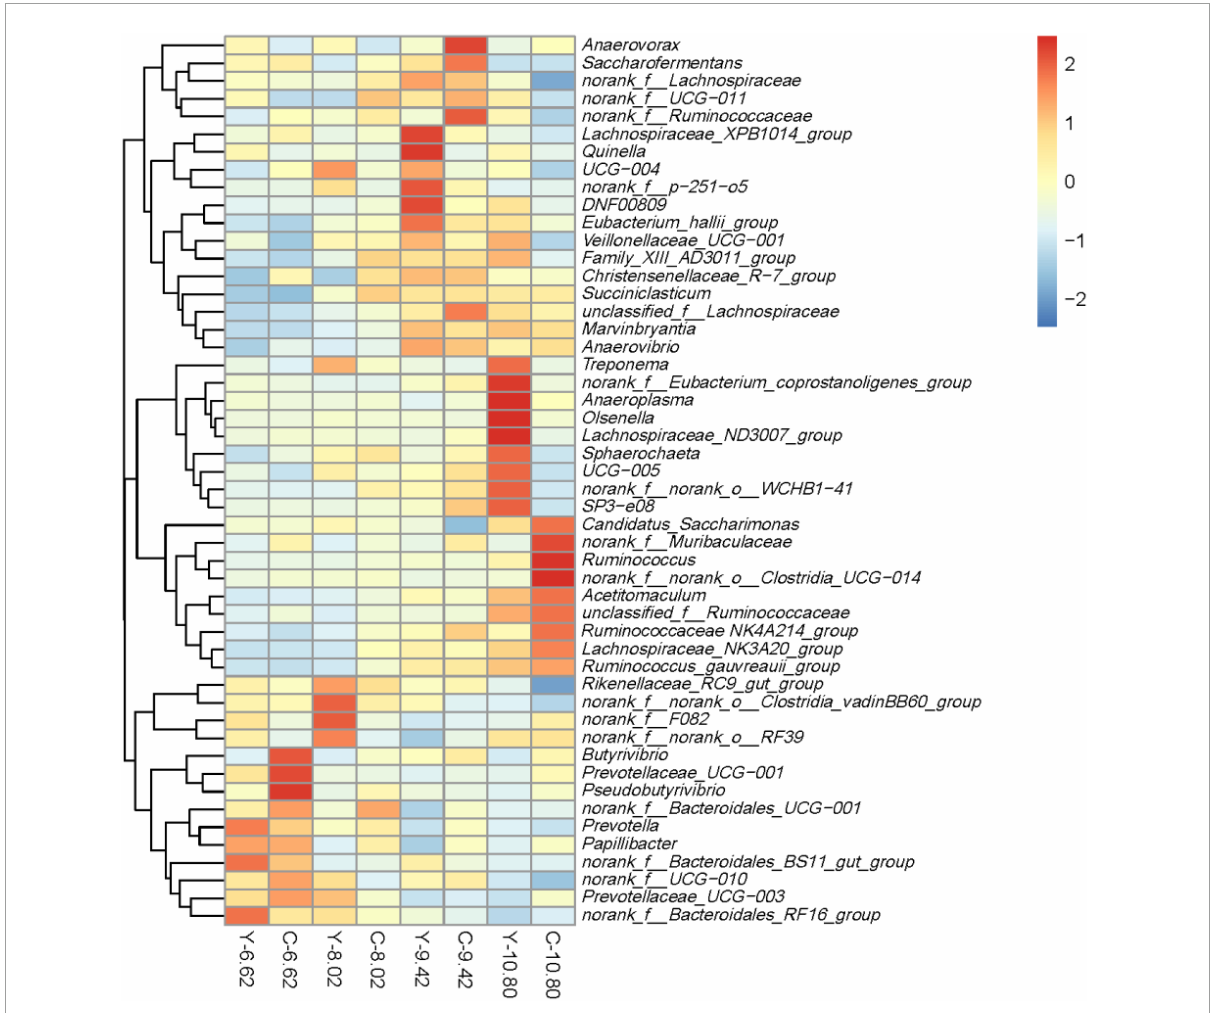
FIGURE5 Relative abundances of the top 50 bacterial sequence variants at the genus level in the rumen of yaks (Y) and Qaidam cattle (C) fed diets differing in energy level (MJ ME/kg DM).